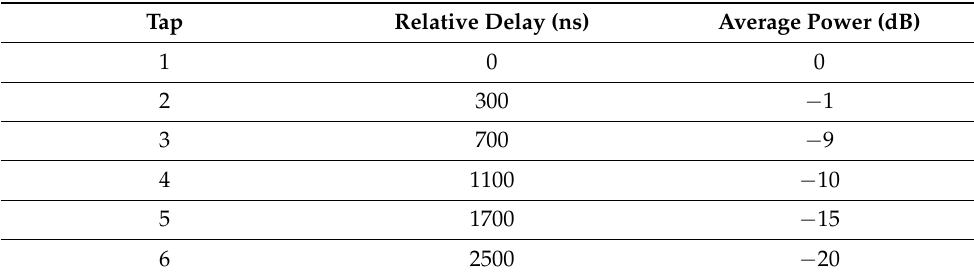
Table 3. Frequency-Selective